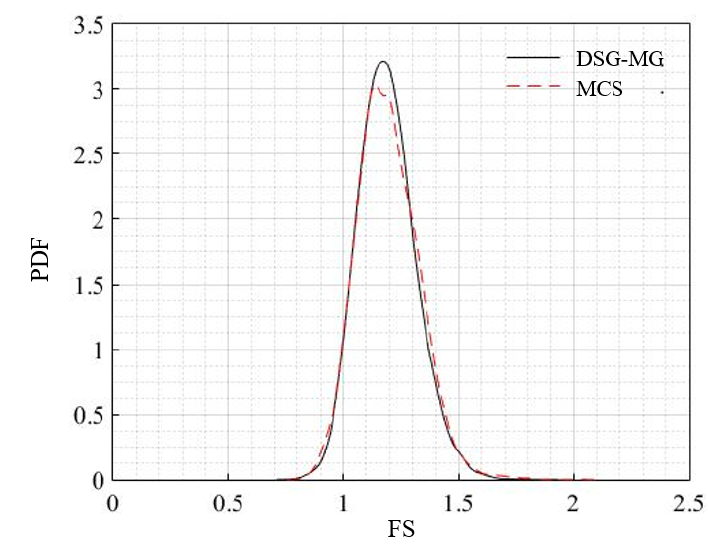
Figure 10. PDFs of the FS obtained by DSG–MG and MCS.